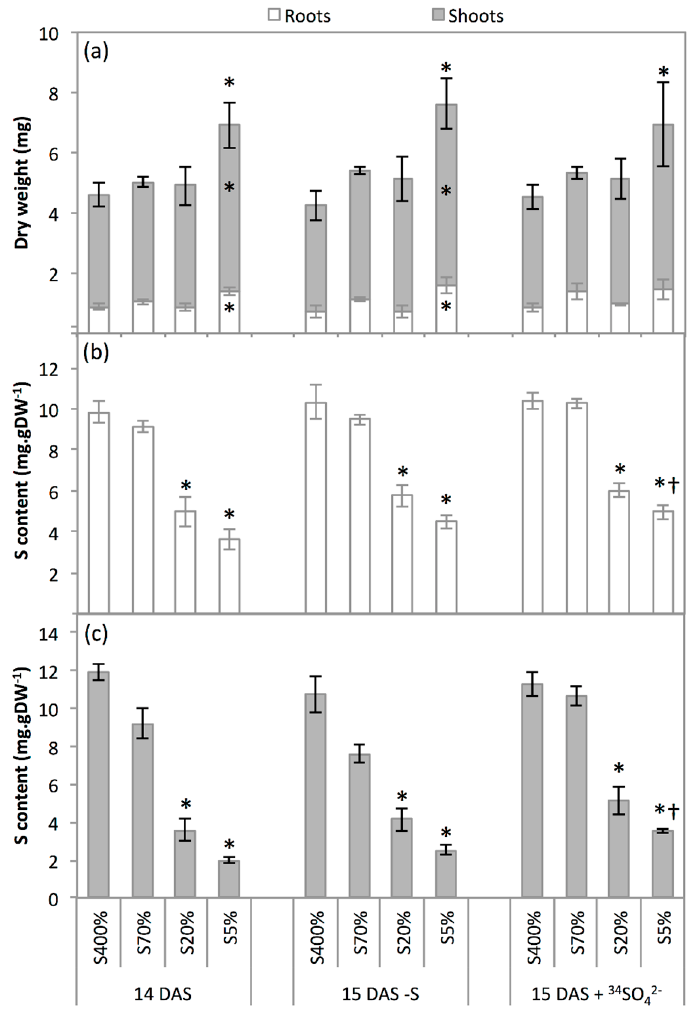
Figure 2. Dry weight and S content of green seedlings shoots and roots. ( a ) Dry weight of green seedlings shoots and roots. ( b ) S content of green seedlings roots. ( c ) S content of green seedlings shoots. Data were acquired 14 days after sowing on water (14 DAS) and after 24-h treatment of 14 DAS seedlings with 508.7 µM 34 SO 42 − at 5 atom% excess (15 DAS + 34 SO 42 − ) and with 8.7 µM SO 42 − (15 DAS-S). Seedlings were grown from seeds harvested on plants subjected to plethoric S nutrition (400% of plant S needs provided, S400% seeds) or subjected to a S limitation from the beginning of plant growth with 70%, 20% and 5% of plant S needs provided (S70%, S20% and S5% seeds, respectively). Values correspond to means ± SE (n = 3). * Significant difference from the value of S400% green seedlings ( p < 0.05). † Significant difference from the corresponding value at 14 DAS ( p < 0.05). In panel ( a ), signs (* and/or †) on the top of the bars are for the whole plant (shoot and root), while signs inside the bar are for root or shoot specifically.